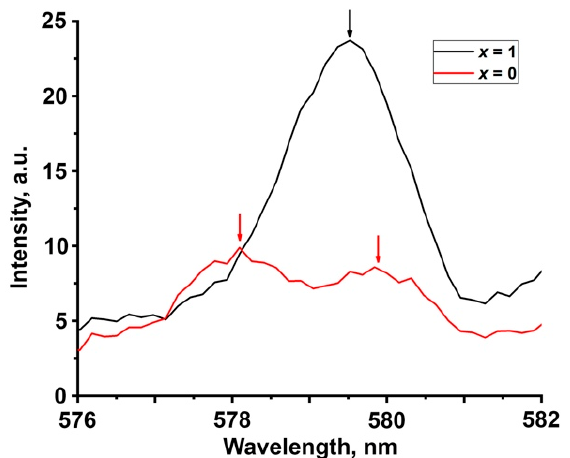
Figure 5. PL spectra of Ca 9- x Zn x Gd 0.9 Eu 0.1 (PO 4 ) 7 x = 0 (red), 1 (black) ( λ ex = 163 nm) at 300 K ( a ) and 6K ( b ). The inset shows the detailed PL spectra in the 300–320 nm region for both temperatures.